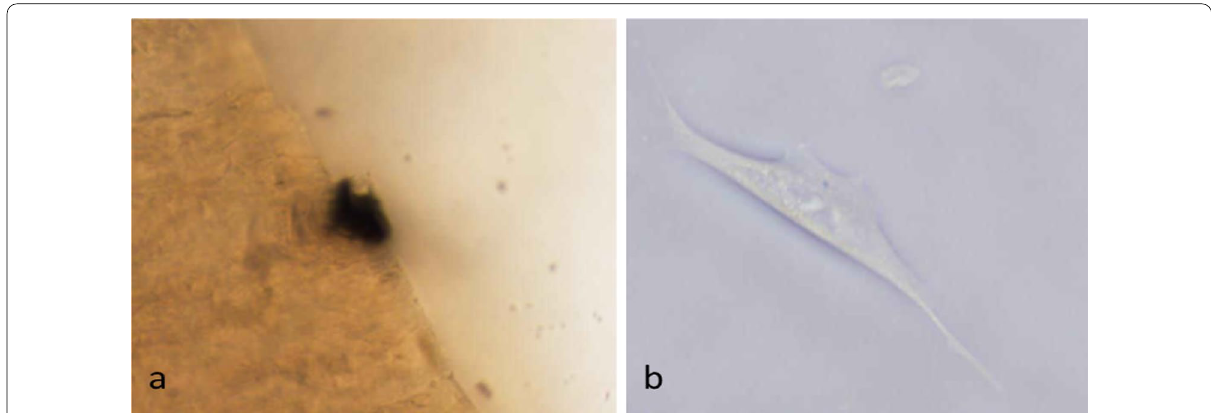
Fig. 6 Morphological features of stem cells grew in culture medium with HiMedia’s FBS: a sprouting from umbilical cord explant under 10X b Stem cell-derived from explant under 40X as observed under inverted microscope Olympus 1X73. Comparatively and drastically low growth was observed with HiMedia